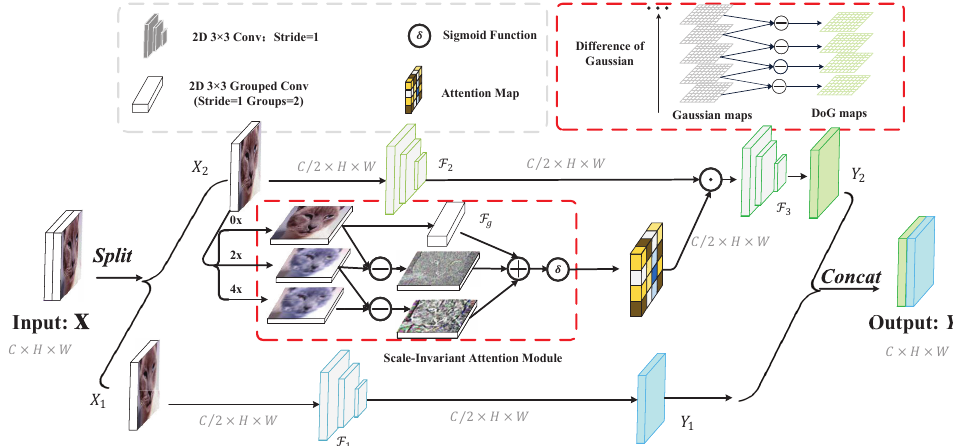
Figure 2. Structural diagram of the proposed Calibrated Convolution with Gaussian of